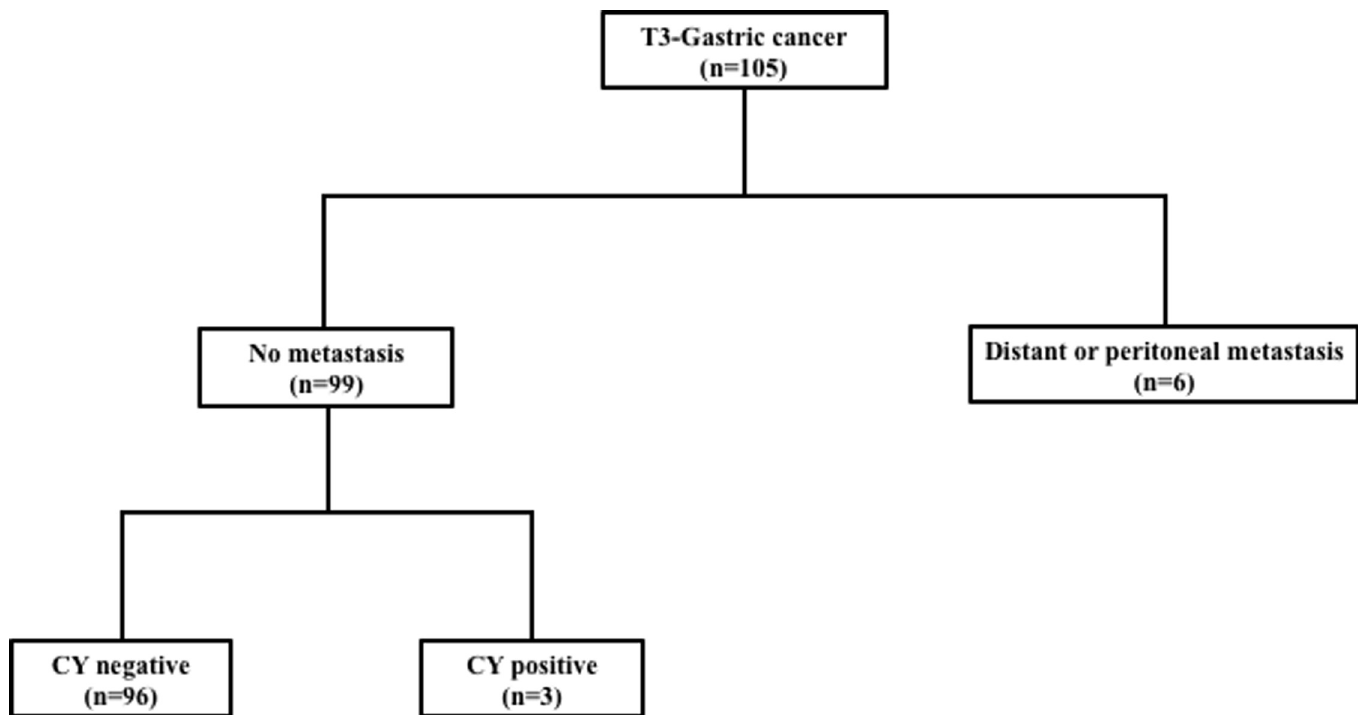
Fig 1. The inclusion criteria in flowchart. The inclusion criteria were as follows; 1. histologically proven gastric adenocarcinoma; 2. the depth of tumor invasion was T3; 3. curative operation; 4. intraoperative peritoneal lavage cytology-negative (Fig 1).